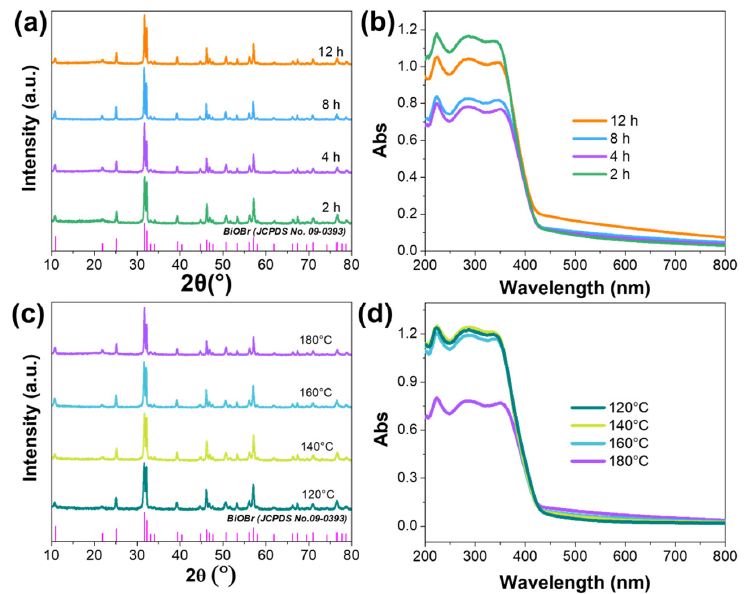
Figure 4. Comparison of products prepared in different times ( a ) XRD patterns, and ( b ) DRS spectra. Comparison of products prepared in different temperatures ( c ) XRD patterns, and ( d ) DRS spectra.